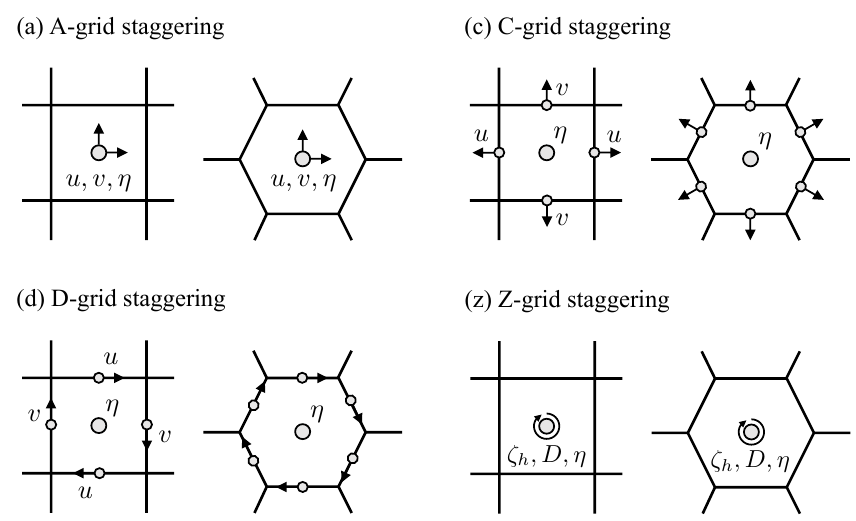
Figure 6. Horizontal staggering options represented among DCMIP models, in this case depicted on a rectilinear grid and geodesic grid. Here, η denotes the buoyancy